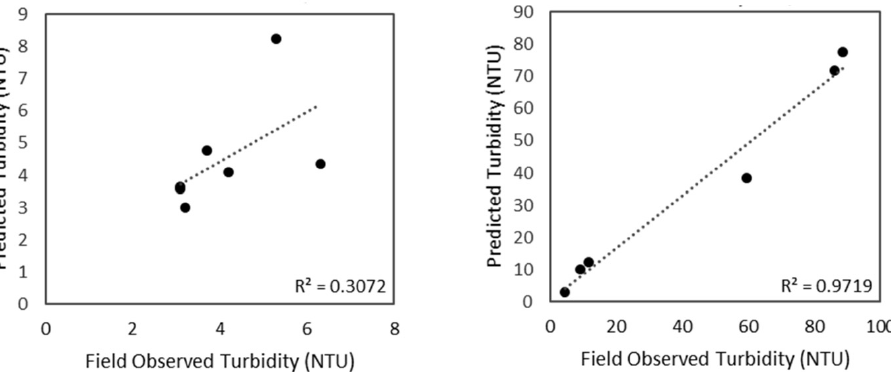
Figure 10. Scatterplots illustrating the relationship between the predicted and observed turbidity values for 2 December 2018 ( left ) and 13 February 2019 ( right ). Table 6. Accuracy assessments of turbidity estimation model’s performance for December and February image acquisitions.